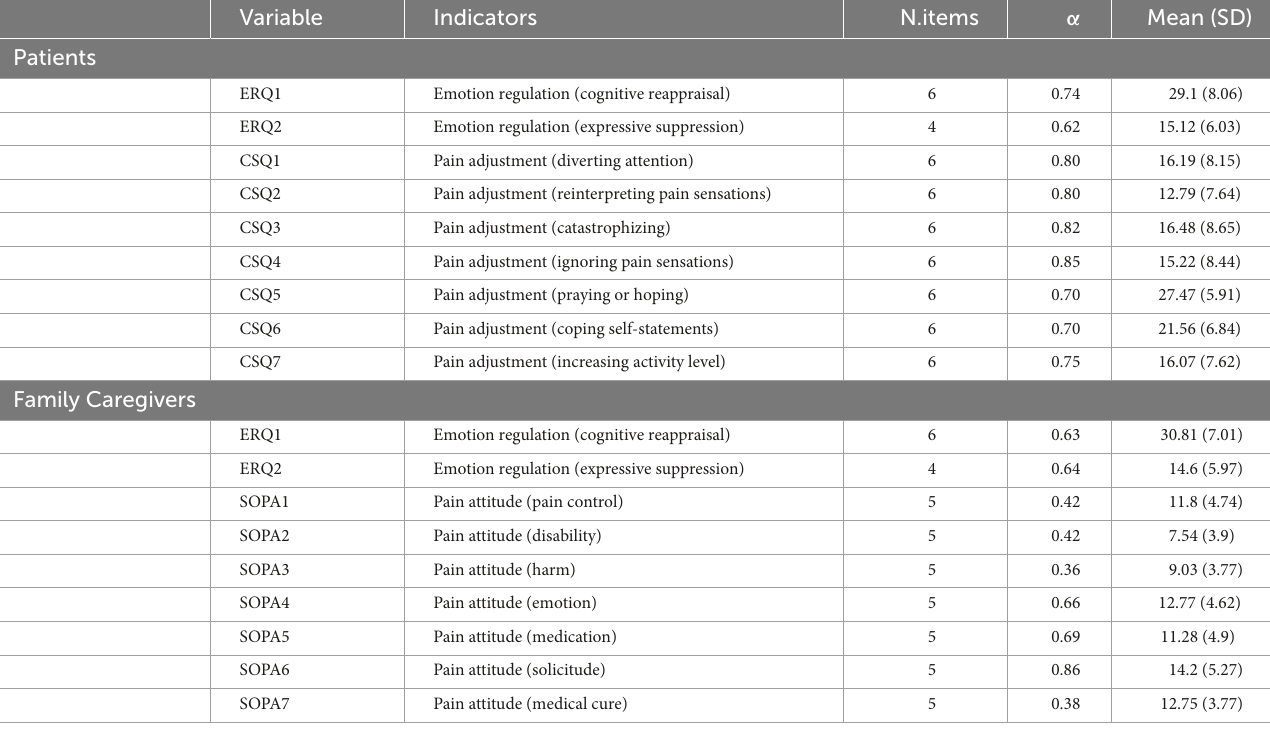
TABLE 3 Psychometric properties of measures used in the